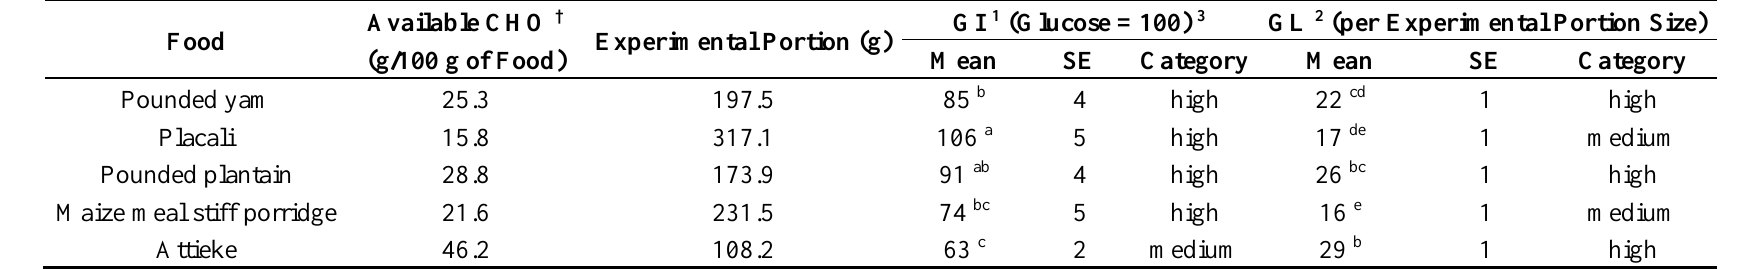
Table 3. Incremental area under the curve and glycaemic index/load values of five staple